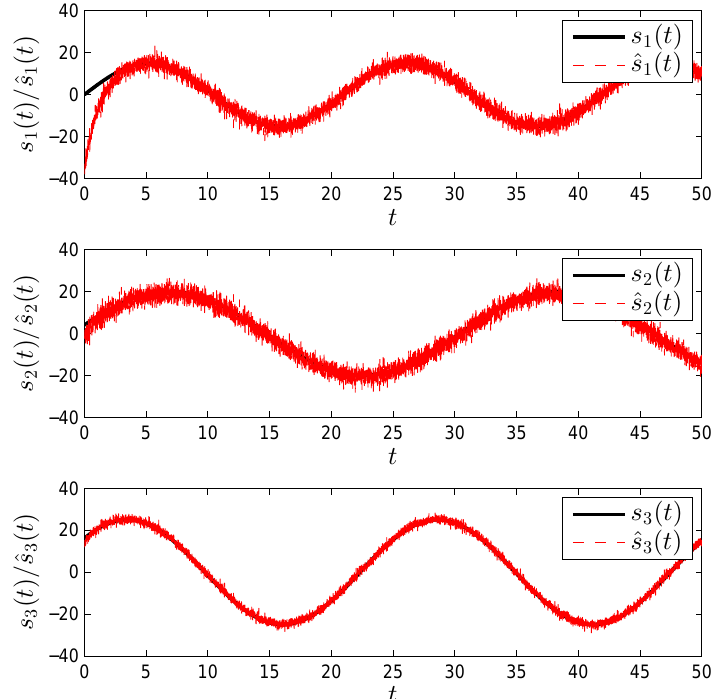
Figure 8. The recovered messages (cid:98) s i ( t ) from the n receive